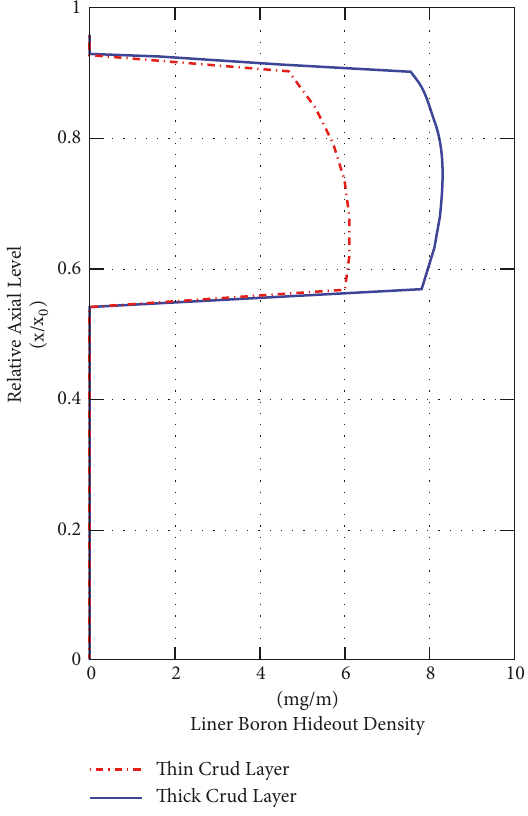
Figure 6: Boron hideout amount along